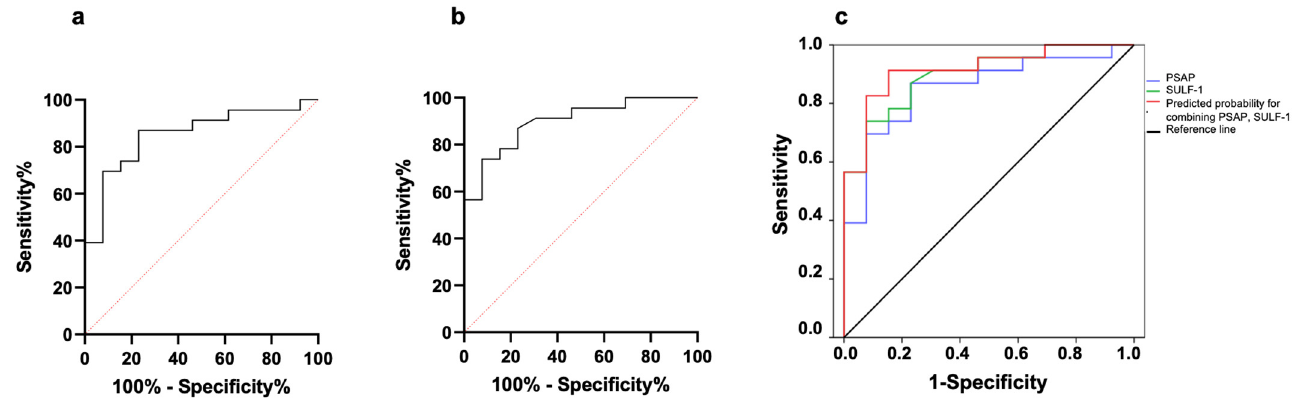
Figure 2. Diagnostic efficiency of individual and combined biomarkers for discriminating MPM ( n = 23) from BPD ( n = 13) patients. ( a ) ROC analysis showing specificity and sensitivity for PSAP. ( b ) ROC analysis showing specificity and sensitivity for SULF-1. ( c ) Individual and combined ROCs. AUC values were 0.853 and 0.898 for PSAP and SULF-1, respectively, while the combination predicted an AUC of 0.916.